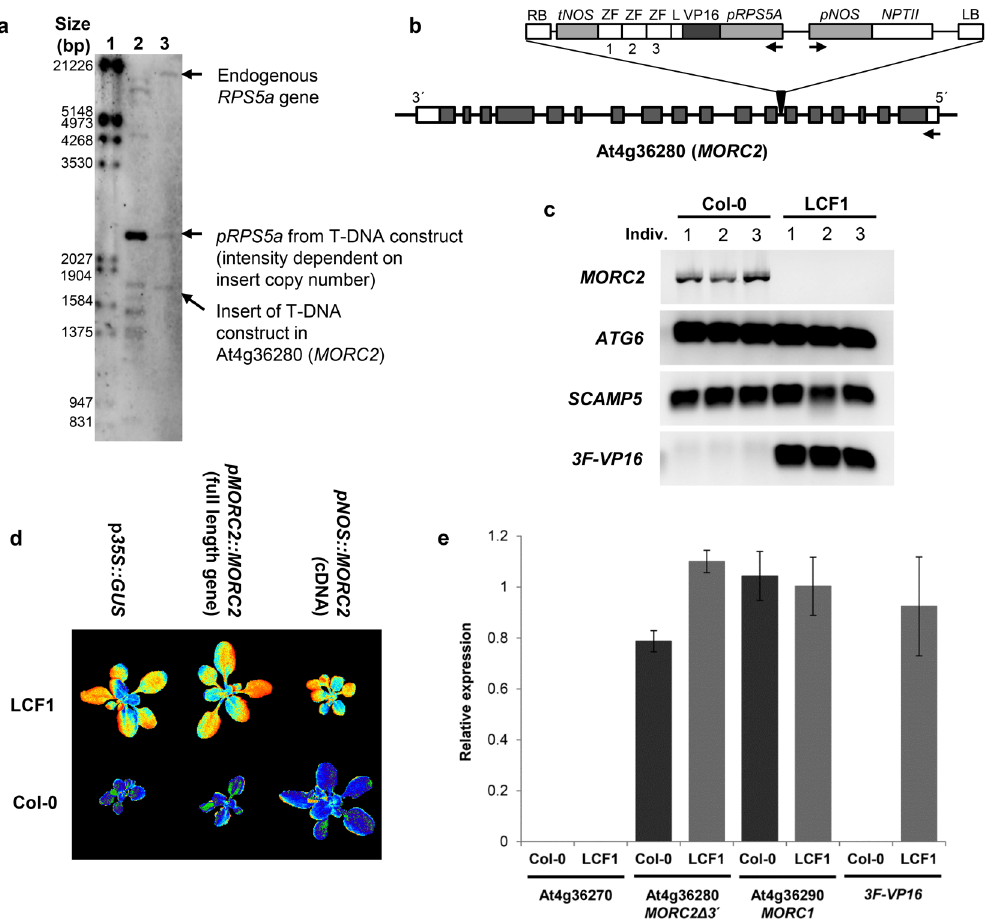
Figure 2. Genetic analysis of LCF1. ( a ) Southern blot on Nco I digested genomic DNA (gDNA) of empty vector control plants (Col-0 transformed with pRF-VP16-Kana not containing a 3F fragment; lane 2) and LCF1 (lane 3). Lane 1 contains DIG-labelled DNA ladder. The DIG-labelled probe was expected to hybridize with fragments of the promoter of the endogenous RPS5a gene (10695 bp fragment), the RPS5a promoter (p RPS5a ) from the T-DNA construct (2590 bp fragment with intensity depending on the copy number of the insert), and the (3F)-VP16 fusion encoding part of each T-DNA insert in the genome (fragments of ≥ ~1500 bp for LCF1 and ≥ ~800 bp for the empty vector control without 3F). ( b ) Map of the 3F-VP16 encoding T-DNA construct in MORC2 (At4g36280) of LCF1. MORC2 is presented to scale. Exons are presented as grey boxes. 5 ′ and 3 ′ untranslated regions (UTRs) are presented as white boxes. The T-DNA insert is not presented to scale. ( c ) RT- PCR analysis of MORC2 expression in Col-0 and LCF1 plants. The genes ATG6 (At3g61710) and SCAMP5 (At1g32050) serve as a controls for gene expression. Expression of the 3F-VP16 construct in LCF1 was verified as a positive control. ( d ) False color ϕ PSII images of Col-0 and LCF1 plants (T1 generation; obtained through selection with PPT) harboring T-DNA constructs with either the GUS gene under control of the CaMV 35S promoter ( p35S::GUS ), the full length genomic sequence of MORC2 under control of its own promoter and terminator sequences (p MORC::MORC2 ) to assay for complementation, or the cDNA encoding MORC2 under control of the NOS promoter and terminator sequences ( pNOS::MORC2 ) to assay for complementation. The variation in size among the transformants was due to herbicide selection and subsequent transfer from selection medium to soil. ( e ) RT-qPCR analysis of the expression of the 5 ′ end of MORC2 ( MORC2 Δ 3 ′ ) and of the two neighboring genes At4g36270 and At4g36290 ( MORC1 ). Expression of the 3F-VP16 construct in LCF1 was quantified as a positive control. Relative expression values were obtained by normalizing to the expression values of the genes ATG6 and SCAMP5 . Error bars represent SEM values (n = 4). The presented data are the average of two technical